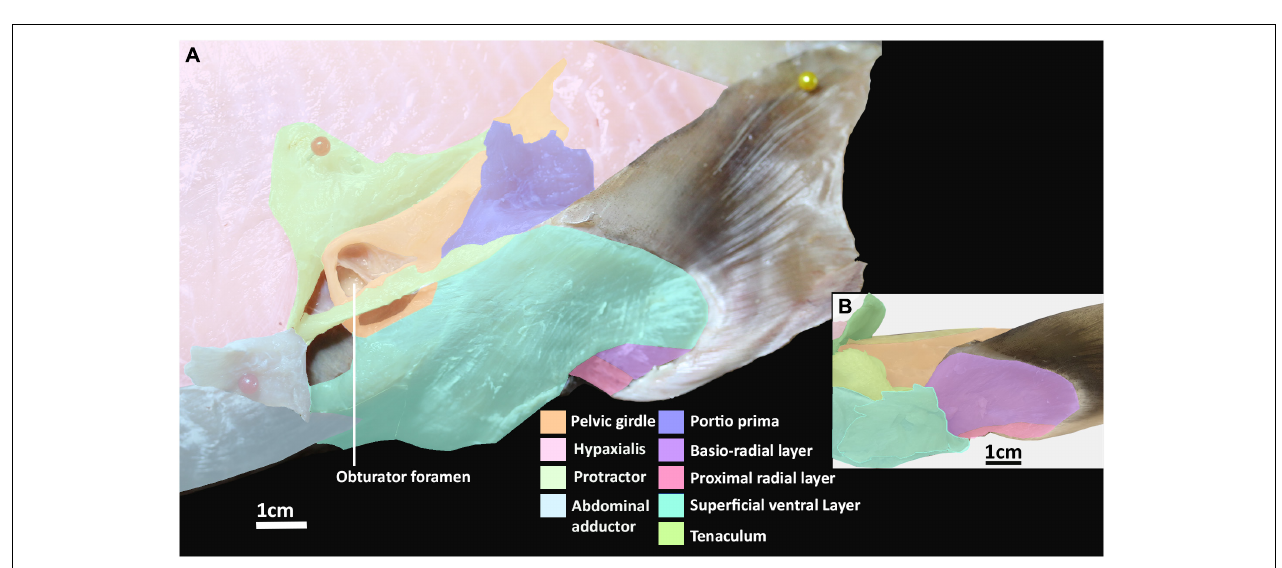
FIGURE 2 | Dissection of the pelvic musculature of an adult elephant shark ( Callorhinchus milii ). (A) Lateral view of the ventral musculature of a female elephant shark, which has been partially dissected, (B) ventral view of the pelvic fin of an adult male elephant shark.